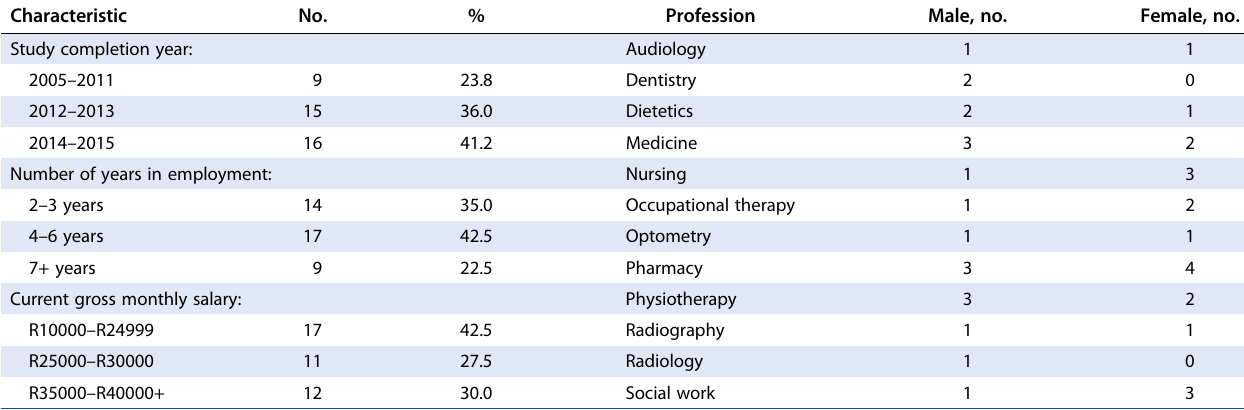
Table 3: Professional characteristics of participants ( n = 40) Characteristic